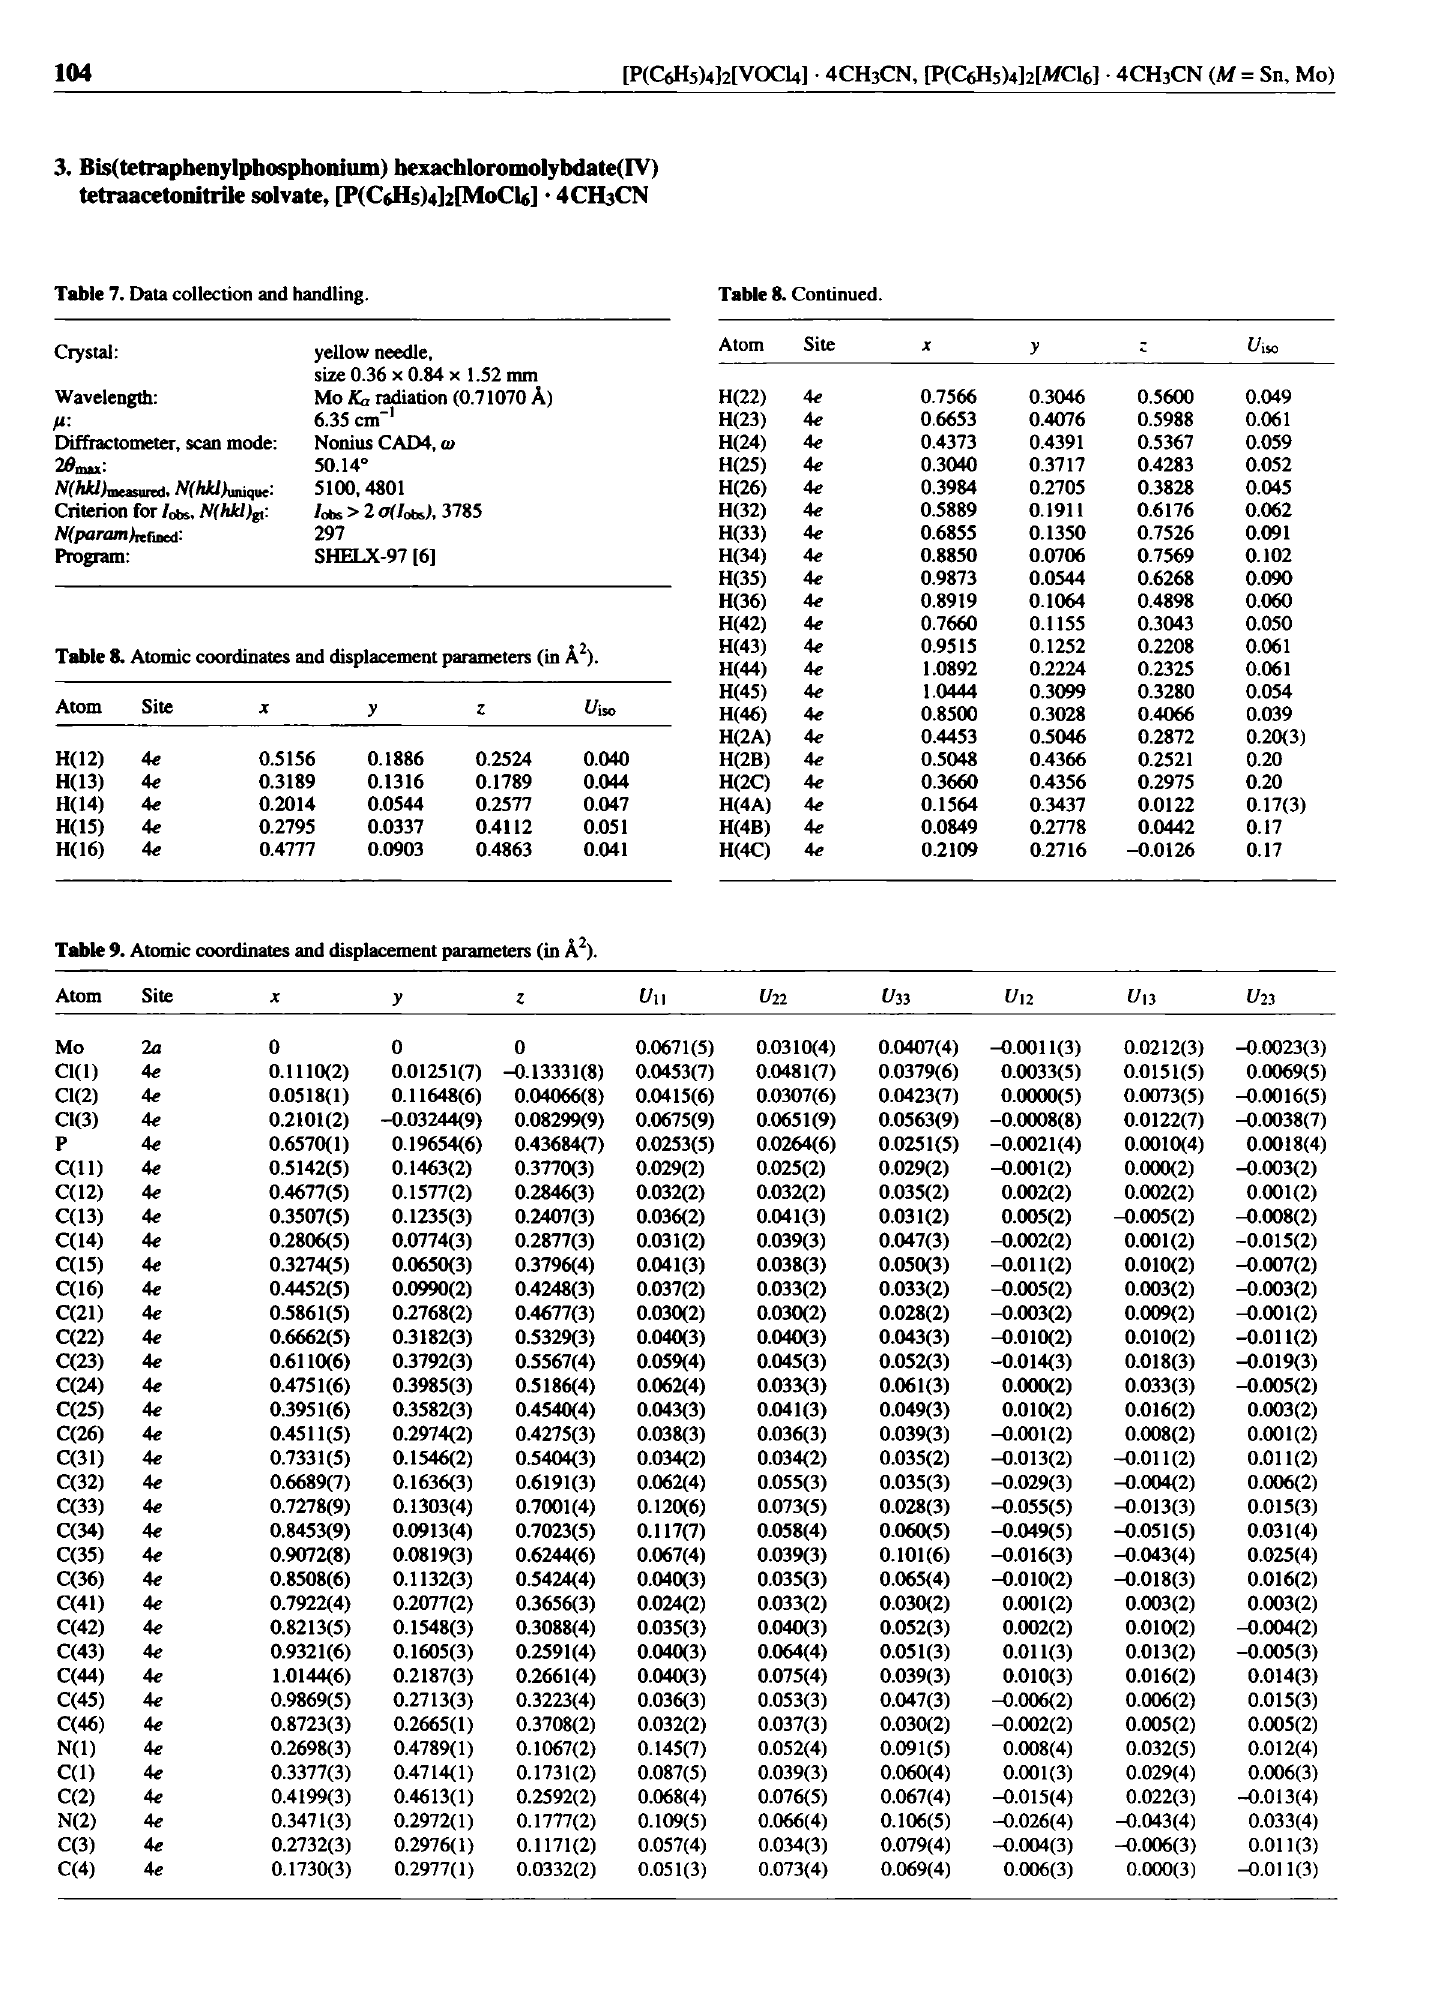
Table 8. Atomic coordinates and displacement parameters (in Â 2 ).